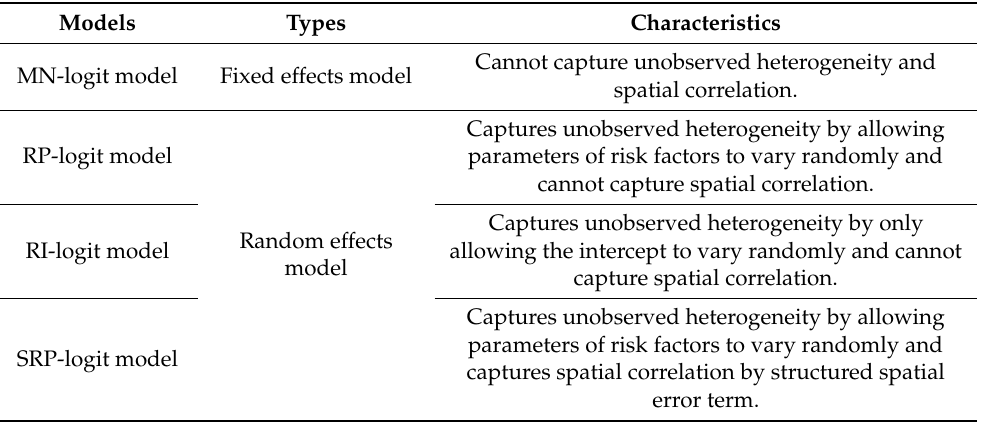
Table 2. Characteristics statistics of crash severity model proposed in this